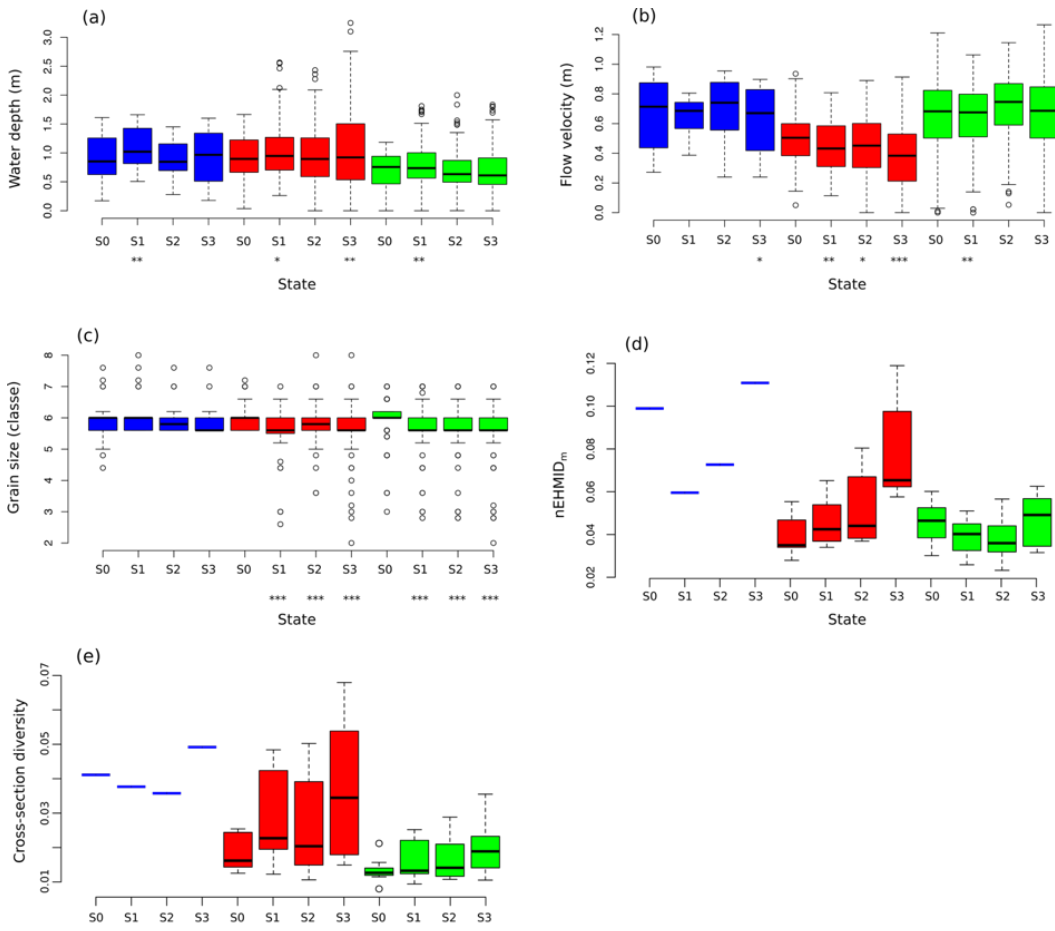
Figure 7. Boxplots of the physical parameters calculated on all cross-sections for each state and for each section at 52 m 3 /s: ( a ) water depth (m), ( b ) flow velocity (m/s), and ( c ) bed grain size. The results of the paired Wilcoxon test performed between each state and the initial state (S 0 ) for each physical variable are indicated as follows: * = p < 0.05, ** = p < 0.01, *** = p < 0.001. The number of sampling points in the upstream, impacted and downstream sections is 11, 74 and 122, respectively. Boxplots ( d ) of the nEHMID m and ( e ) of the CSD index calculated for each cross-section, state and section. The number of cross-sections for the upstream, impacted, and downstream sections is 1, 6, and 11, respectively. Blue, red, and green boxplots correspond to the upstream, impacted, and downstream sections, respectively. S 0 , S 1 , S 2 , and S 3 correspond to each monitoring